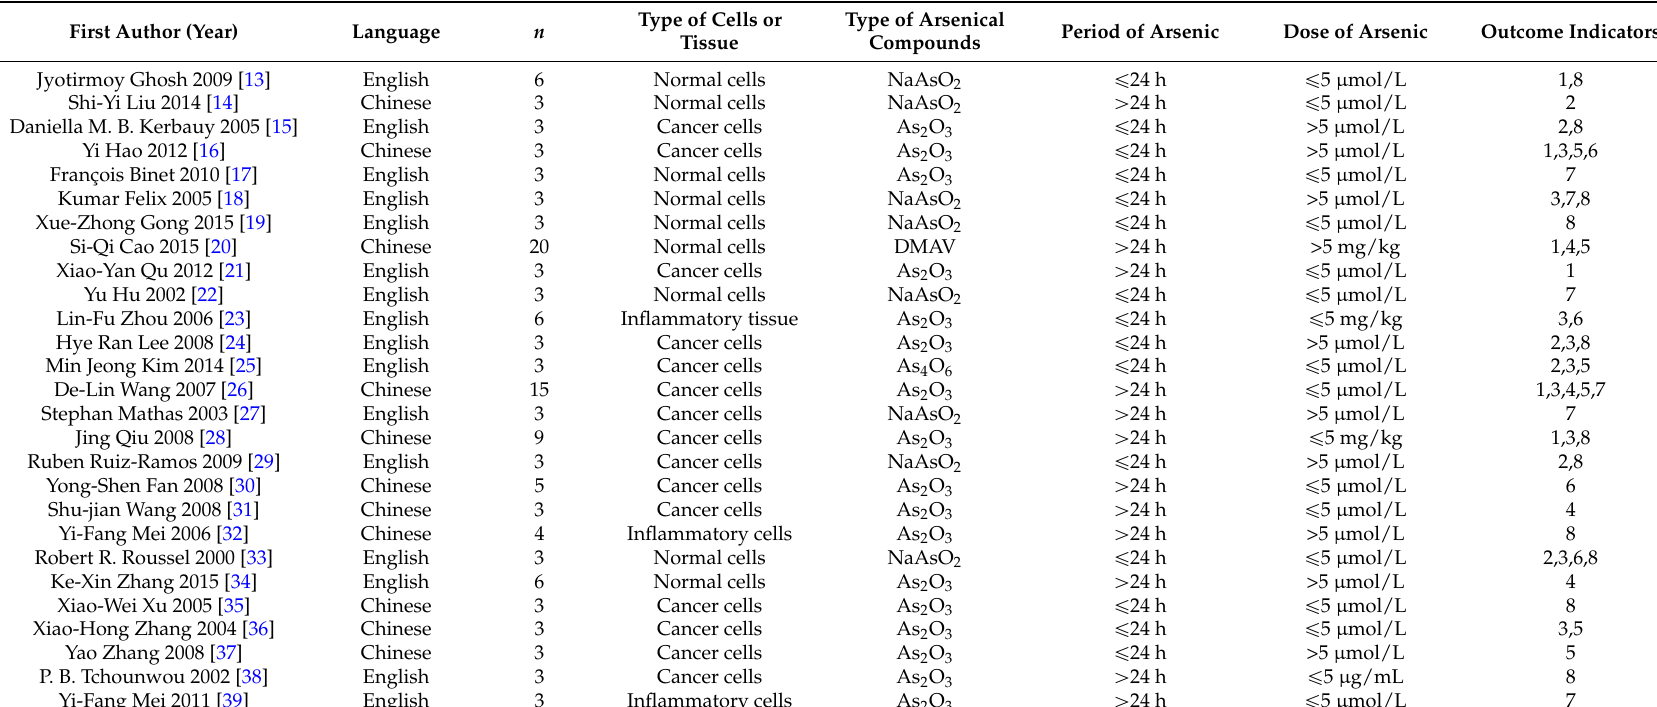
Table 1. Characteristics of the studies included in the